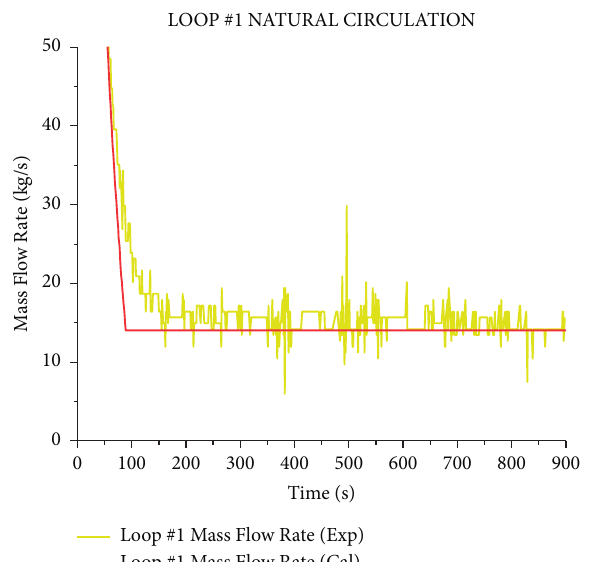
Figure 14: Mass flow rate in loop #1 (Low range).